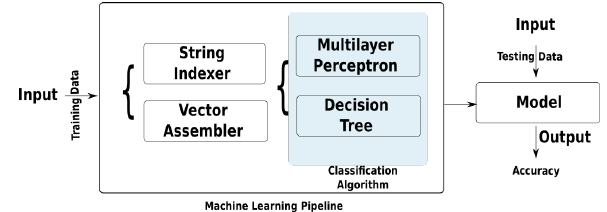
Figure 4. Machine Learning